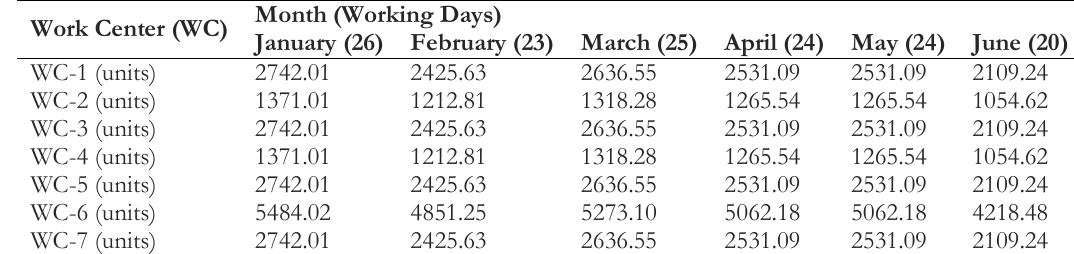
Table 7. Available capacity for IGB.